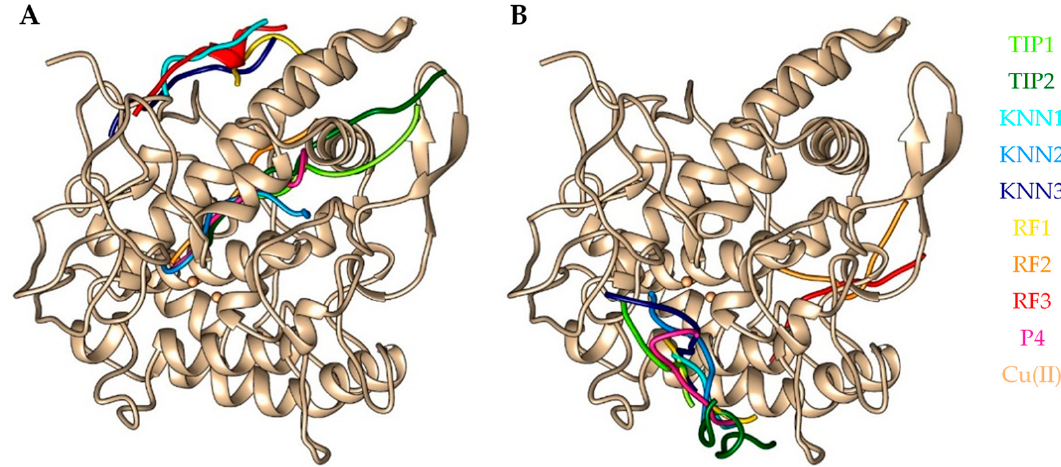
Figure 5. Comparative molecular docking of the hdTIPs and the positive control peptide (P4) on the crystal structure of polyphenol oxidase subunit of tyrosinase (PDB: 2Y9X) from different online protein-peptide docking tools ( A ): GalaxyPepDock and ( B ): HPEPDOCK. The structure of the tyrosinase is shaded in gold, and the peptides are labeled with different colors. Table 2. Calculated binding affinity ( ∆ G), dissociation constant (Kd), and binding energy scores from the molecular docking results from HPEPDOCK of peptides to the tyrosinase based on the PROGIDY and PIMA web servers.